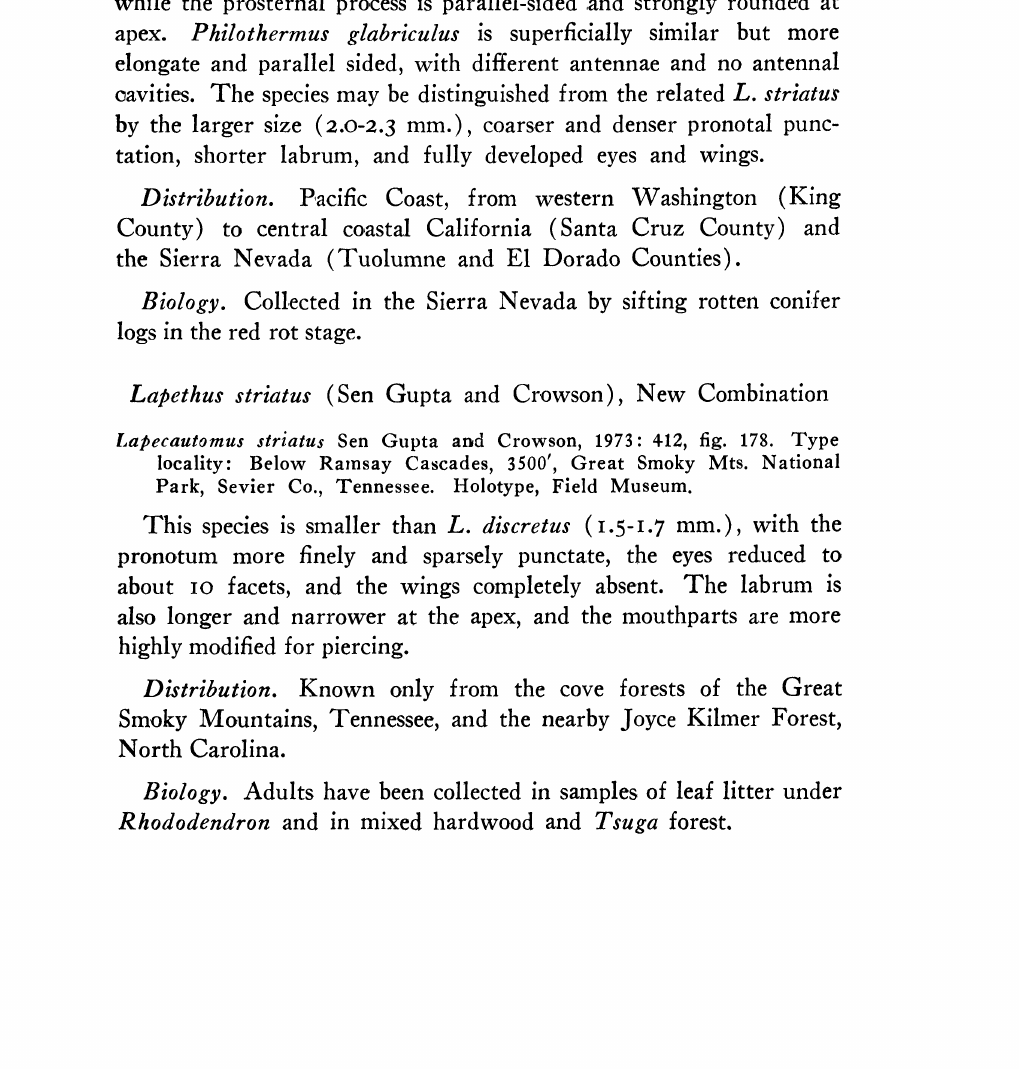
Lapethus discretus Casey, 1890" 318. Type locality" Near Humboldt Bay, Humboldt Co., California. Holotype, No. 48835